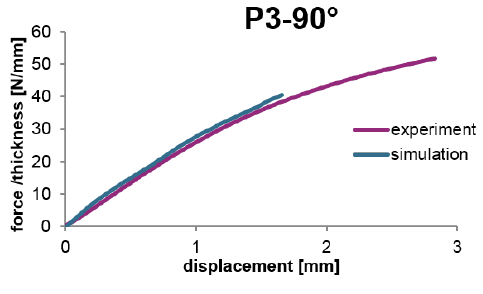
Figure 13. Comparison of force/thickness- displacement curves of experiment and simulation.